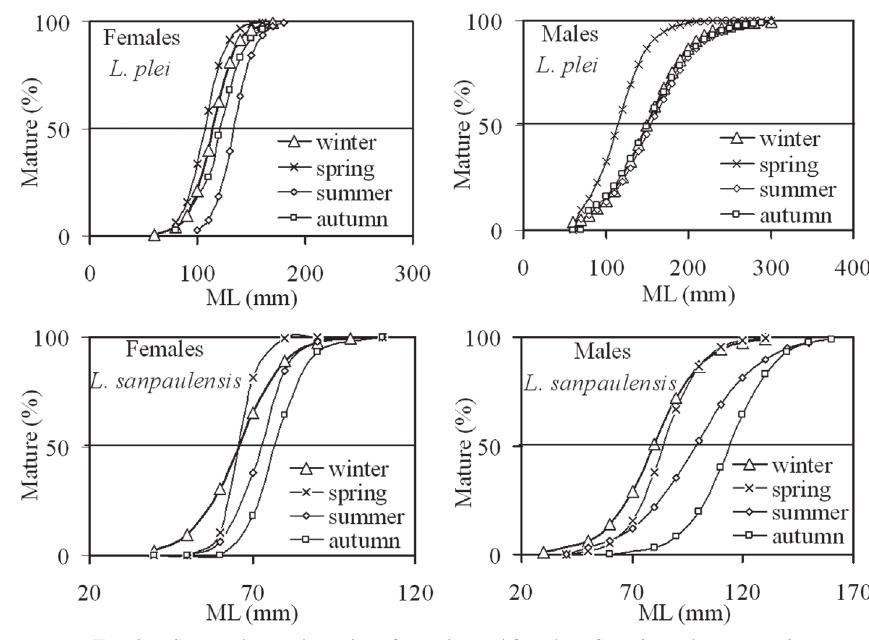
Fig. 3 . – Seasonal maturity ogives for males and females of L. plei and L. sanpaulensis .